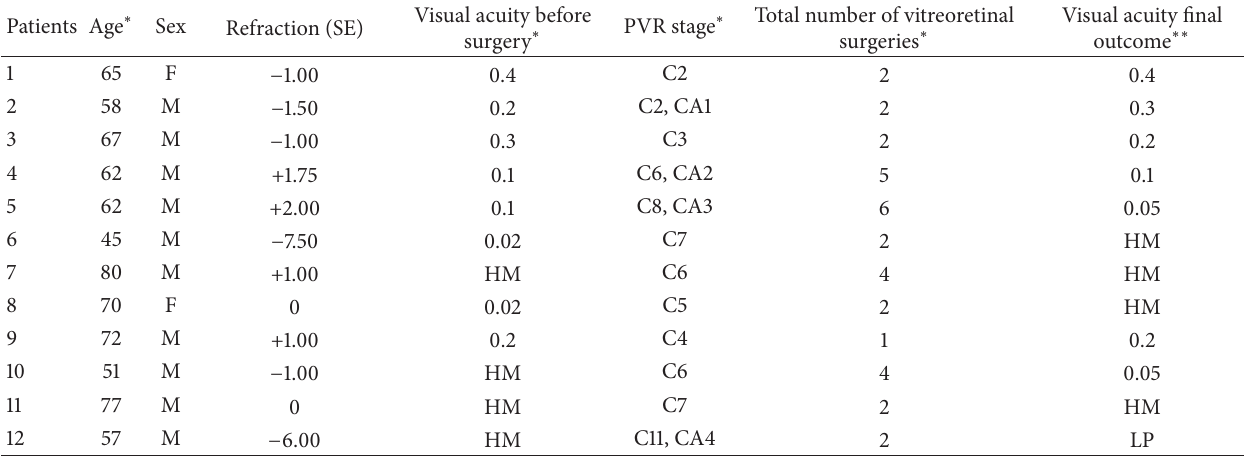
Table 1: Patients’ data in PVR